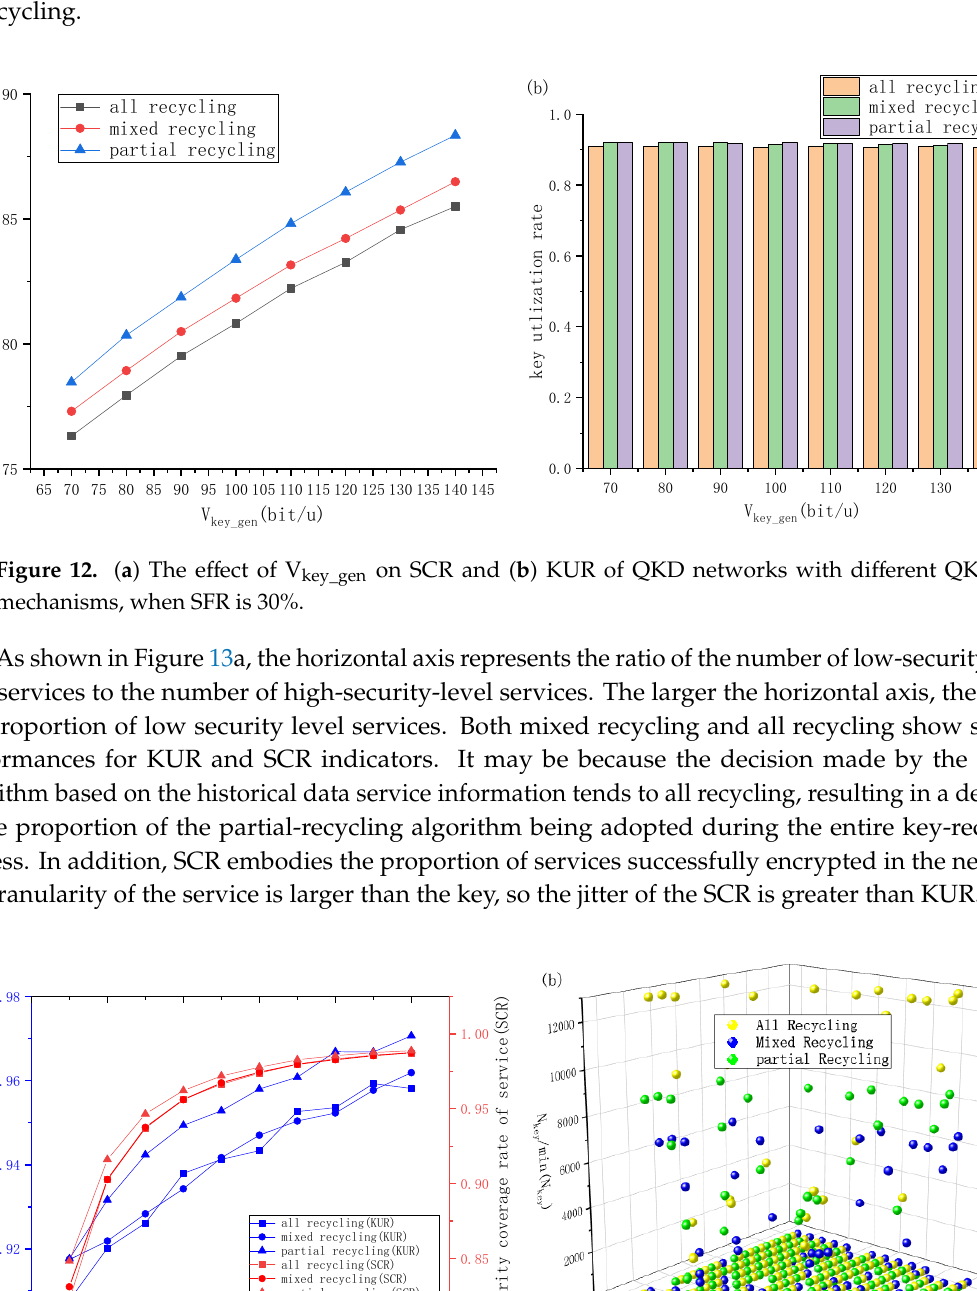
16 of 19 Figure 11. Relative security index of different QKR mechanisms compared to the no-recycling algorithm of traditional QKD networks 6.2. Comparative Analysis between Different QKR Algorithms